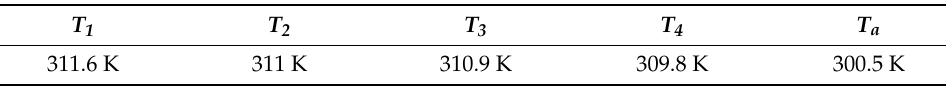
Table 5. Steady state temperature test 45 A. T